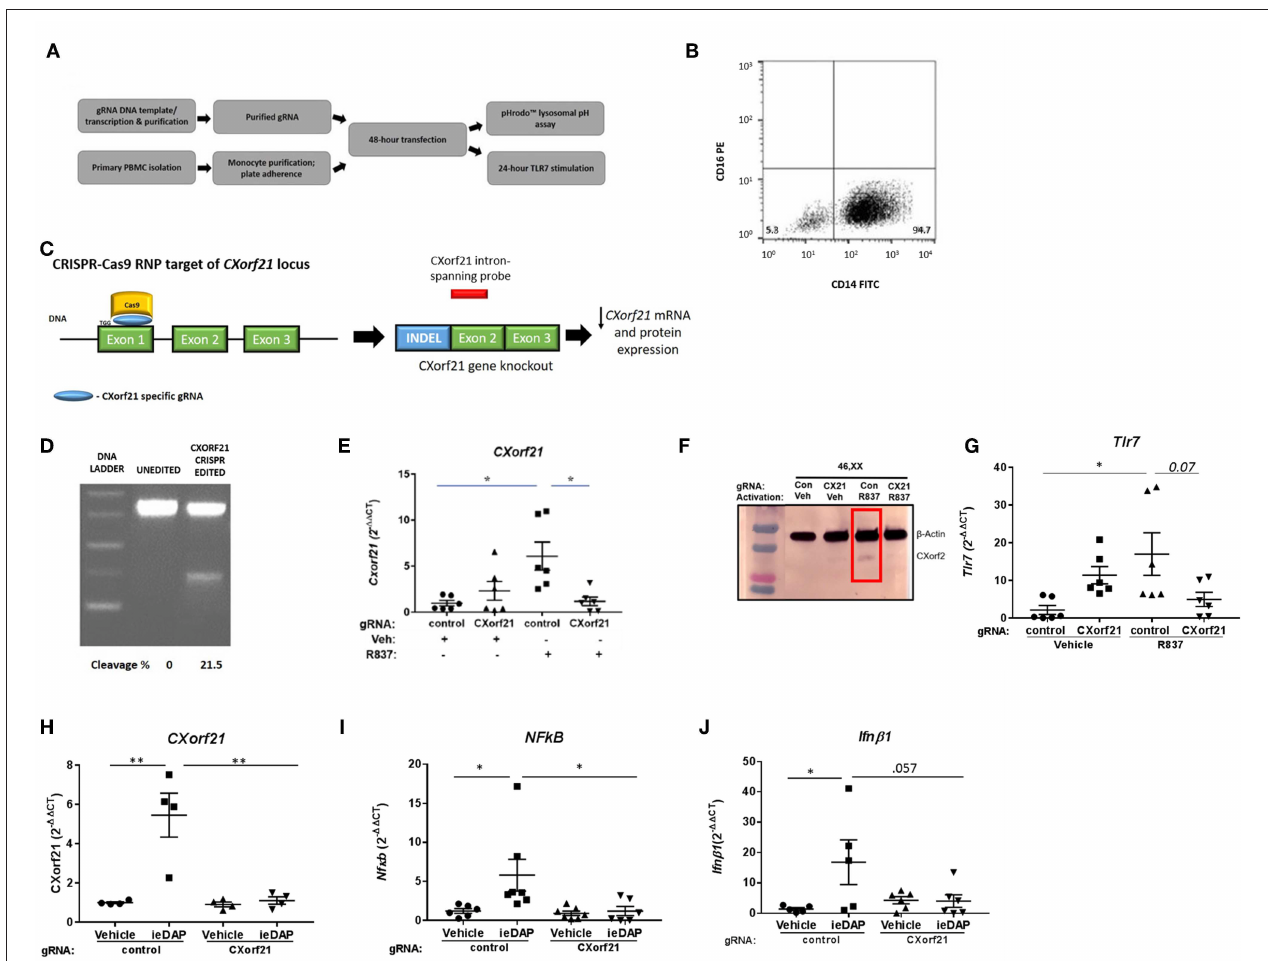
FIGURE 3 | CRISPR-Cas9 knockdown of CXorf21 mRNA and protein silences CXorf21. (A) Workflow of experiment. (B) Purification of classical CD14 + /CD16- monocytes population were confirmed using flow cytometry. (C) Cas9 nuclease RNP targeting exon 1 of CXorf21 locus subsequently resulted in decreased detection of CXorf21 transcript by intron-spanning taq probe. (D) Cas9-gRNA efficiency (18%) was detected enzymatically by GeneArt TM Genomic Detection Kit. Percentage of cleavages was determined with Gel Analyzer and calculation described in methods. (E) RT-qPCR of CXorf21 mRNA expression from primary monocytes from 46, XX female transfected with control (Con) or CXorf21 -specific gRNA (CX21). Ligand stimulation were performed for 24h with vehicle (Veh) or R837 (1 µ M). Fold changes for female samples show relative expression to veh-treated control gRNA female monocytes. Data represents monocytes from 6 female subjects plated in replicates of 3. Error bars represent SEM. One-way ANOVA Kruskal-Wallis nonparametric test with a Dunn’s multiple comparisons. * p < 0.05. (F) Total protein extract from 46,XX female primary monocytes subjected to SDS-PAGE. Western blotting using human anti-CXorf21 antibody (34 kD) identifying bands at the appropriate molecular weight. Human anti-alpha actin (42 kD) is shown as a loading control. (l-r) lane 1 (control gRNA) and 2 ( CXorf21 gRNA) are healthy 46,XX female monocytes treated with vehicle and lanes 3 and 4 are treated with R837 . (G) RT-qPCR of Tlr7 mRNA expression from female primary monocytes transfected with control (Con) or CXorf21-specific gRNA (CX21). Ligand stimulation were performed for 24h with vehicle (Veh) or R837 (1 µ M). Fold changes for female samples show relative expression to female Con-Veh. RT-qPCR of (H) CXorf21 , (I) NFkB1 , and (J) Ifnb1 mRNA expression from primary monocytes from 46, XX female transfected with control (Con) or CXorf21 -specific gRNA (CX21). Ligand stimulation was performed for 24h with vehicle (Veh) or NOD1 agonist ie-DAP (10mM). ** p <